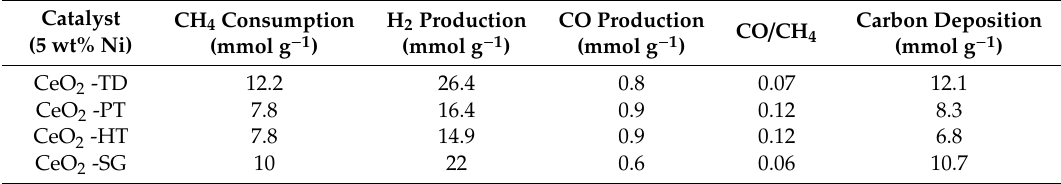
Table 1. Quantity of CH 4 consumed, H 2 and CO formed (mmol g − 1 ), and molar ratio of CO / CH 4 obtained after 30 min of methane decomposition (20% CH 4 / He) conducted at 750 ◦ C. Also shown is the amount of carbon deposited (mmol g − 1 ), which was obtained after TPO following 30 min of methane